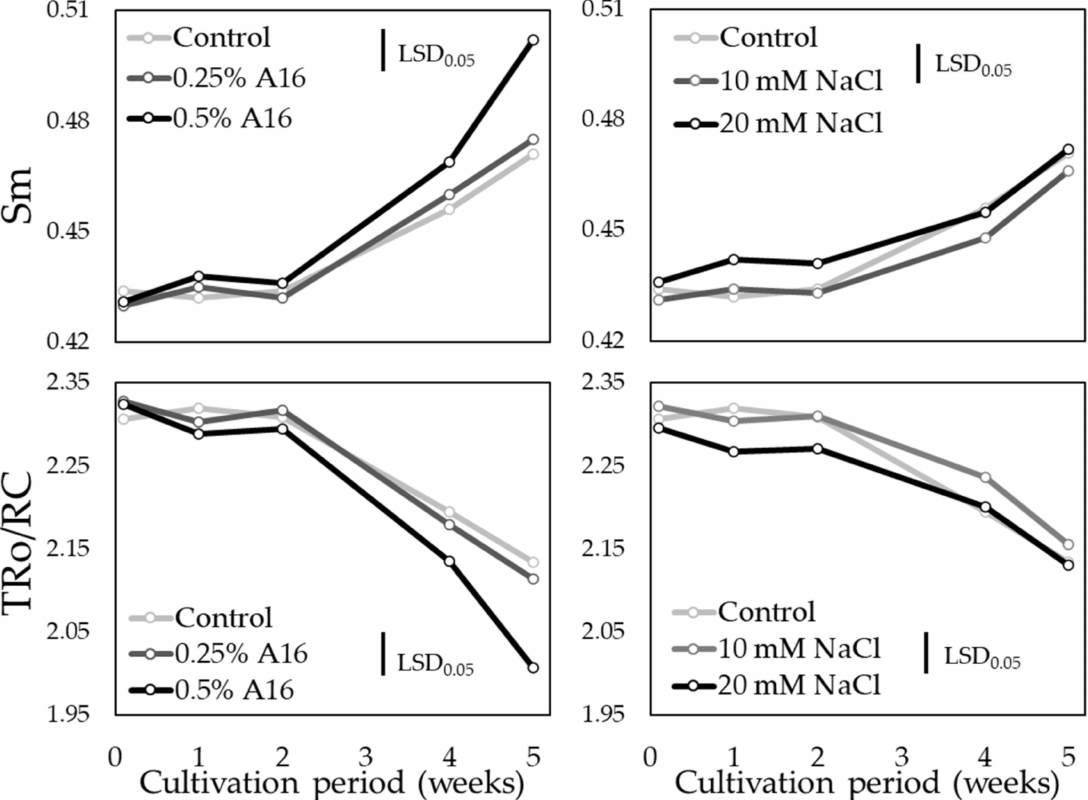
Figure 5. Chlorophyll fluorescence parameters (Sm and TRo/RC) of spearmint plants grown hydroponically in a floating system on a nutrient solution supplemented either with 0, 0.25, or 0.50% of a commercial amino acid solution (Amino16 ® ) or 0, 10, and 20 mM NaCl. Each column is the mean of three replications with 16 plants per replication. Different letters in the columns indicate each treatment (amino acids or NaCl solution). The vertical lines indicate significant differences between mean, according to the least significant differences test values (LSD) at p <